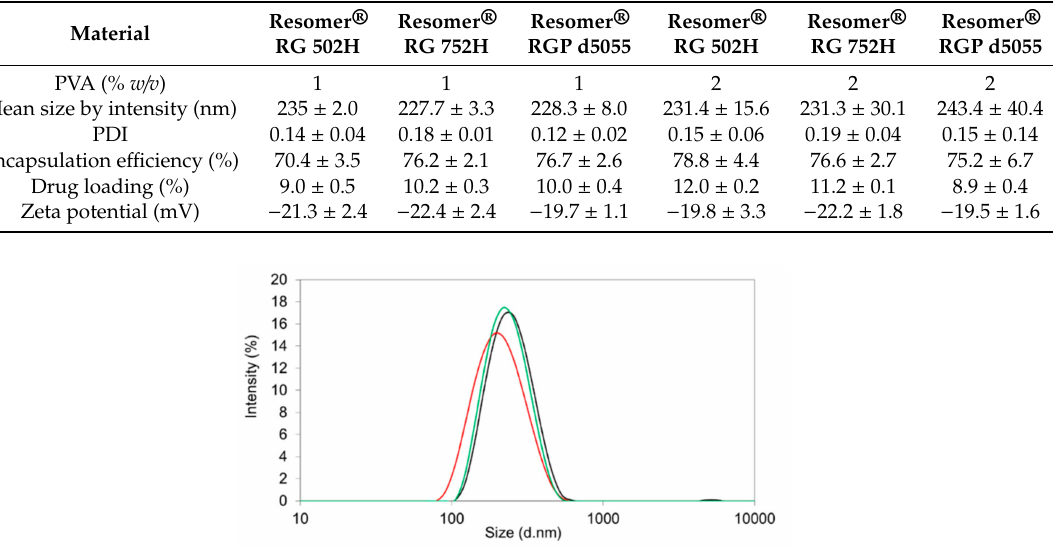
Figure 4. Size distribution by intensity of sorafenib-containing nanoparticles prepared from Resomer ® RG 502H (black line) and Resomer ® RG 752H (red line) polylactic- co -glycolic acid (PLGA) polymers as well as Resomer ® RGP d5055 (green line) by single emulsion